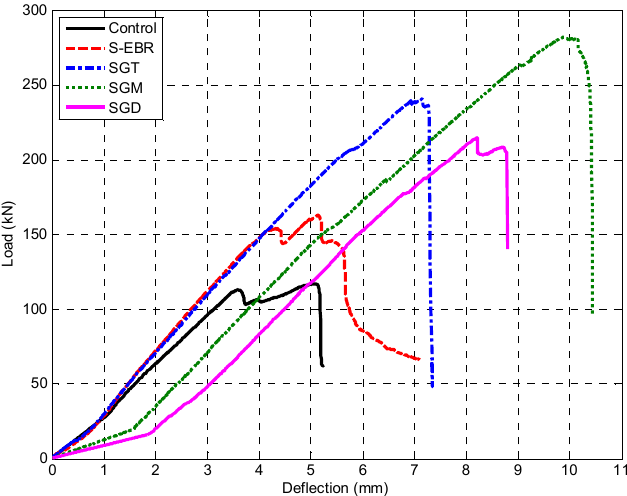
Figure 10. Failure modes: ( a ) SGT beam; ( b ) SGM beam; ( c ) SGD beam.